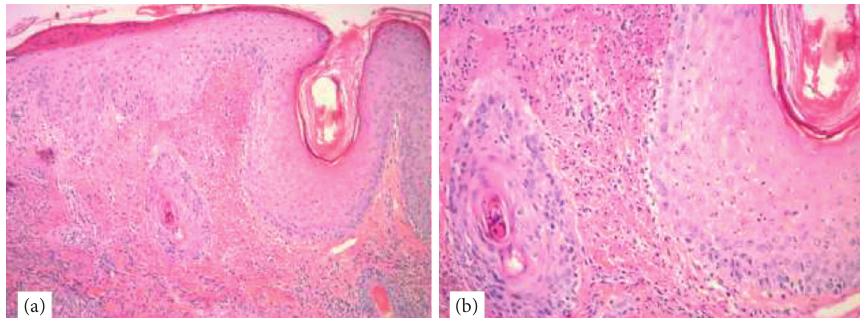
Figure 2: Histologic sections show subcorneal pustules and dense neutrophilic dermal infiltrate ((a)-4X and (b)-10X). Special stains including gram, AFB, and FITE were negative for definitive